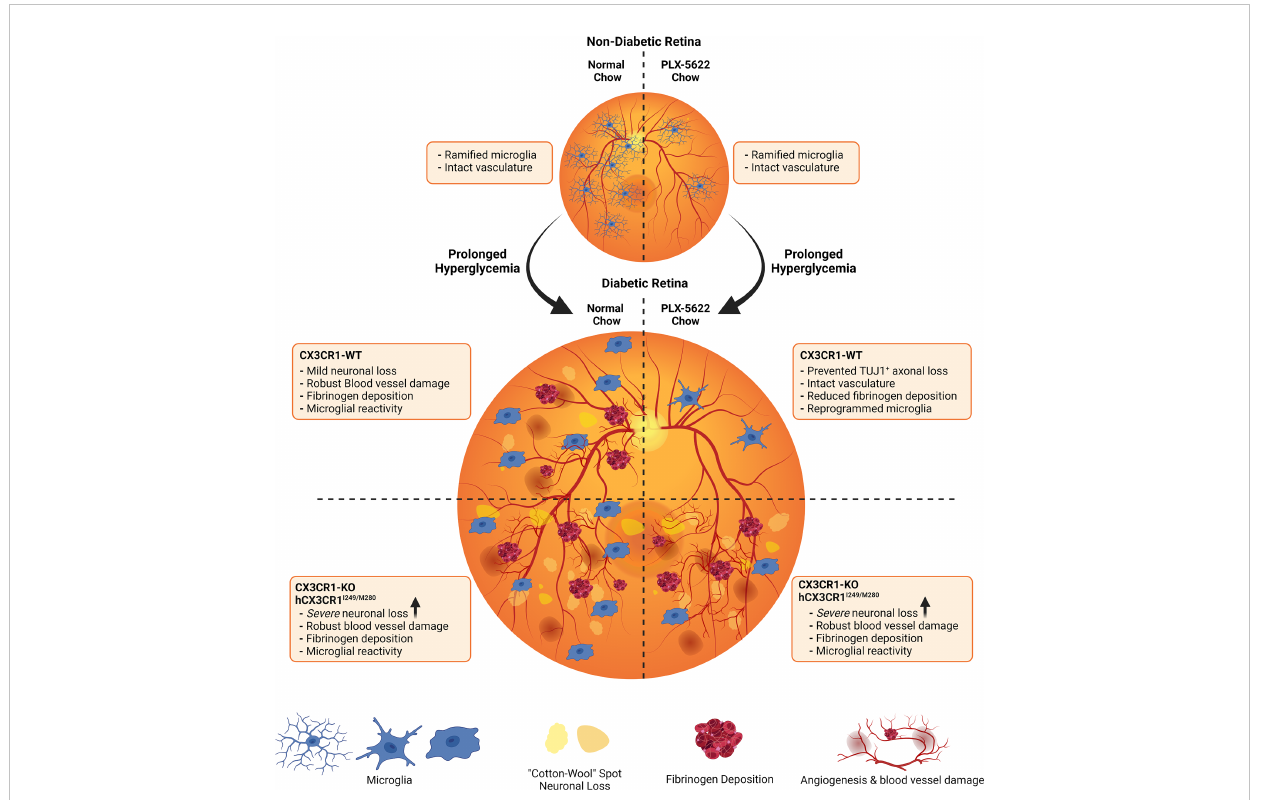
FIGURE 6 Schematic summary: Pharmacological depletion of microglia alleviates neuronal and vascular damage in the diabetic CX3CR1 -WT retina but not in CX3CR1 -KO or hCX3CR1 I249/M280 -expressing retina. In the non-diabetic retina, normal chow and PLX-5622 chow treated CX3CR1 -WT, CX3CR1 -KO, and hCX3CR1 I249/M280 mice have intact vasculature and rami fi ed microglia. PLX-5622 chow treatment induces robust microglia depletion in CX3CR1 -WT, CX3CR1 -KO, and hCX3CR1 I249/M280 mice. Prolonged hyperglycemia results in angiogenesis, vascular damage and fi brinogen deposition in CX3CR1 -WT, CX3CR1 -KO, and hCX3CR1 I249/M280 mice. Additionally, diabetic CX3CR1 -KO, and hCX3CR1 I249/M280 mice are more susceptible to neuronal and axonal loss. CSF-1R antagonism alleviates vascular damage and fi brinogen deposition and prevents neuronal loss in the